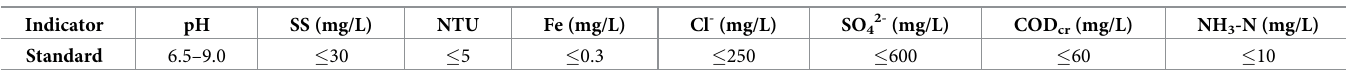
Table 3. Water quality standards for industrial uses based on eight indicators.